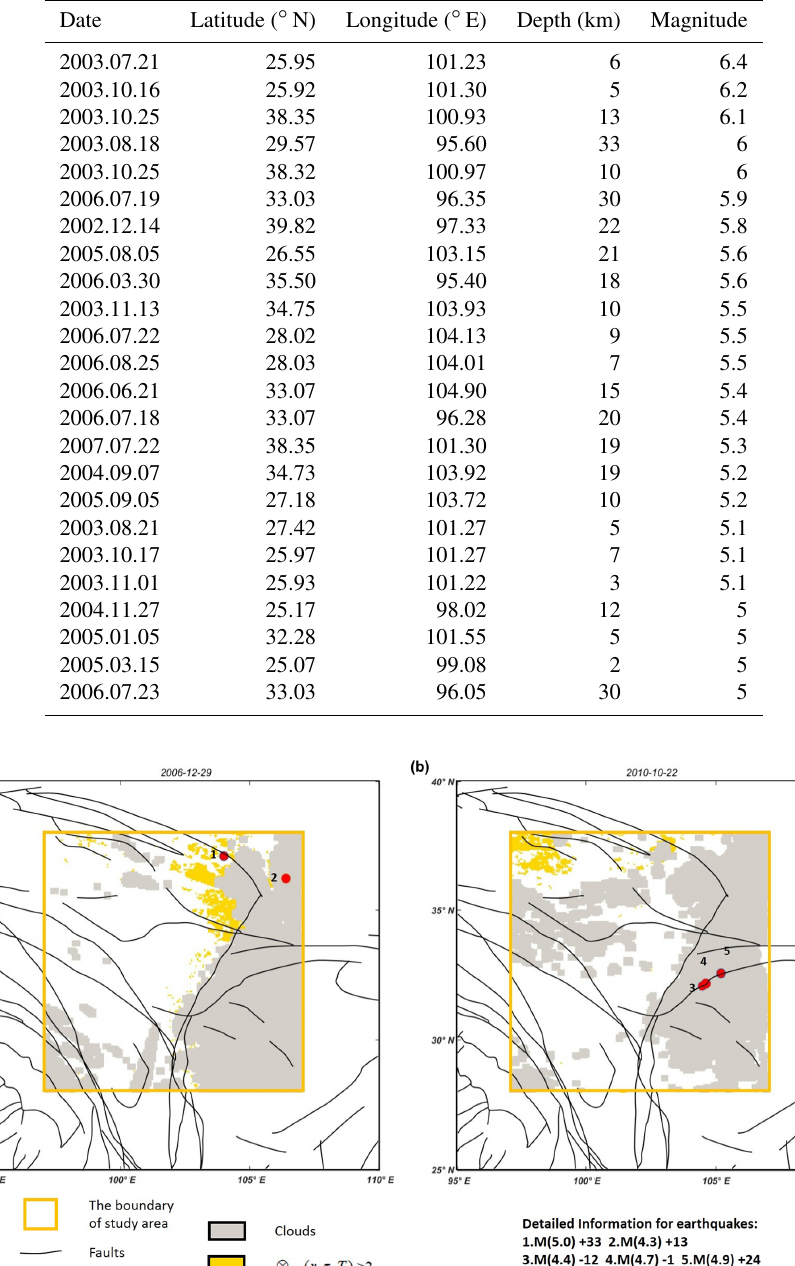
of TIR anomaly are 29 December 2006 and 22 October